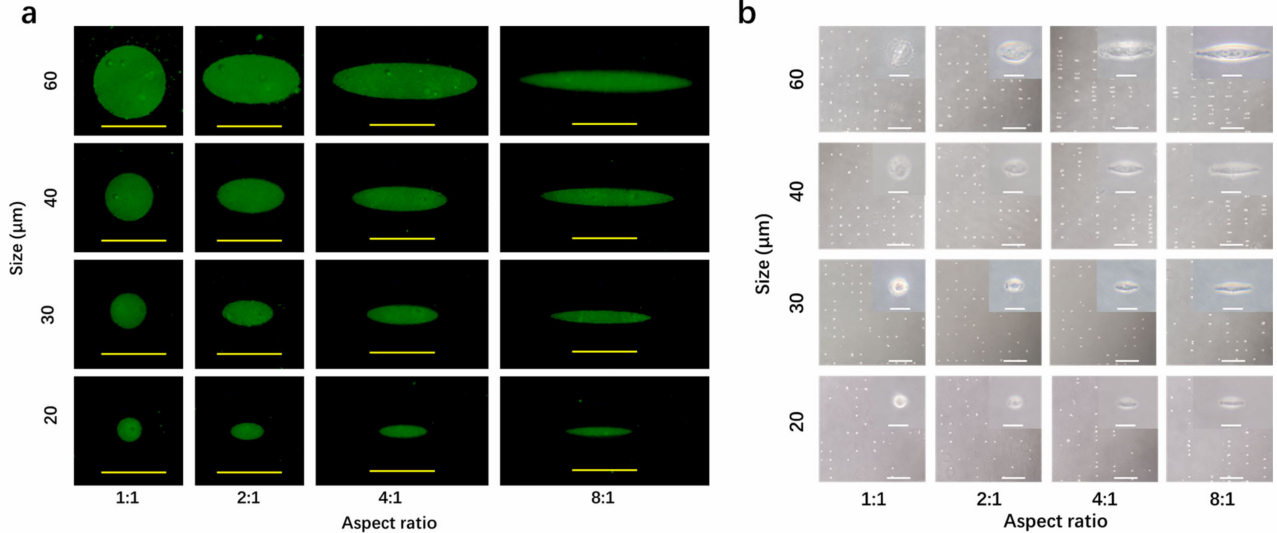
Figure 3. ( a ) Fluorescence photomicrographs of fibronectin-coated micropatterns. Scale bar = 50 µ m. ( b ) Phase-contrast photomicrographs of breast cancer cells after culture on the micropatterned surfaces for 24 h. The inserts are high-magnification photomicrographs of the micropatterned cells. Scale bars of the low- and high-magnification photomicrographs are 500 and 50 µ m,